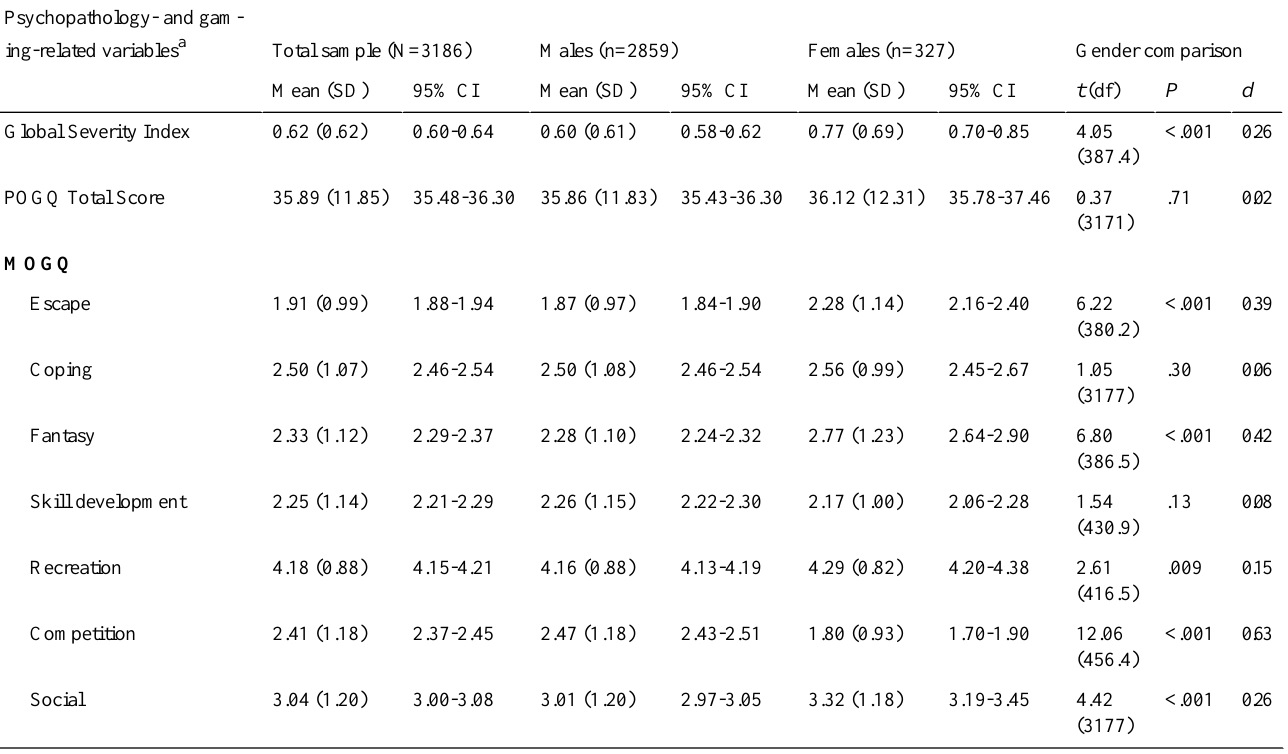
Table 3. Means, standard deviations (SD), and confidence intervals (CI) for both genders and for the total sample and effects sizes (Cohen’s d ).